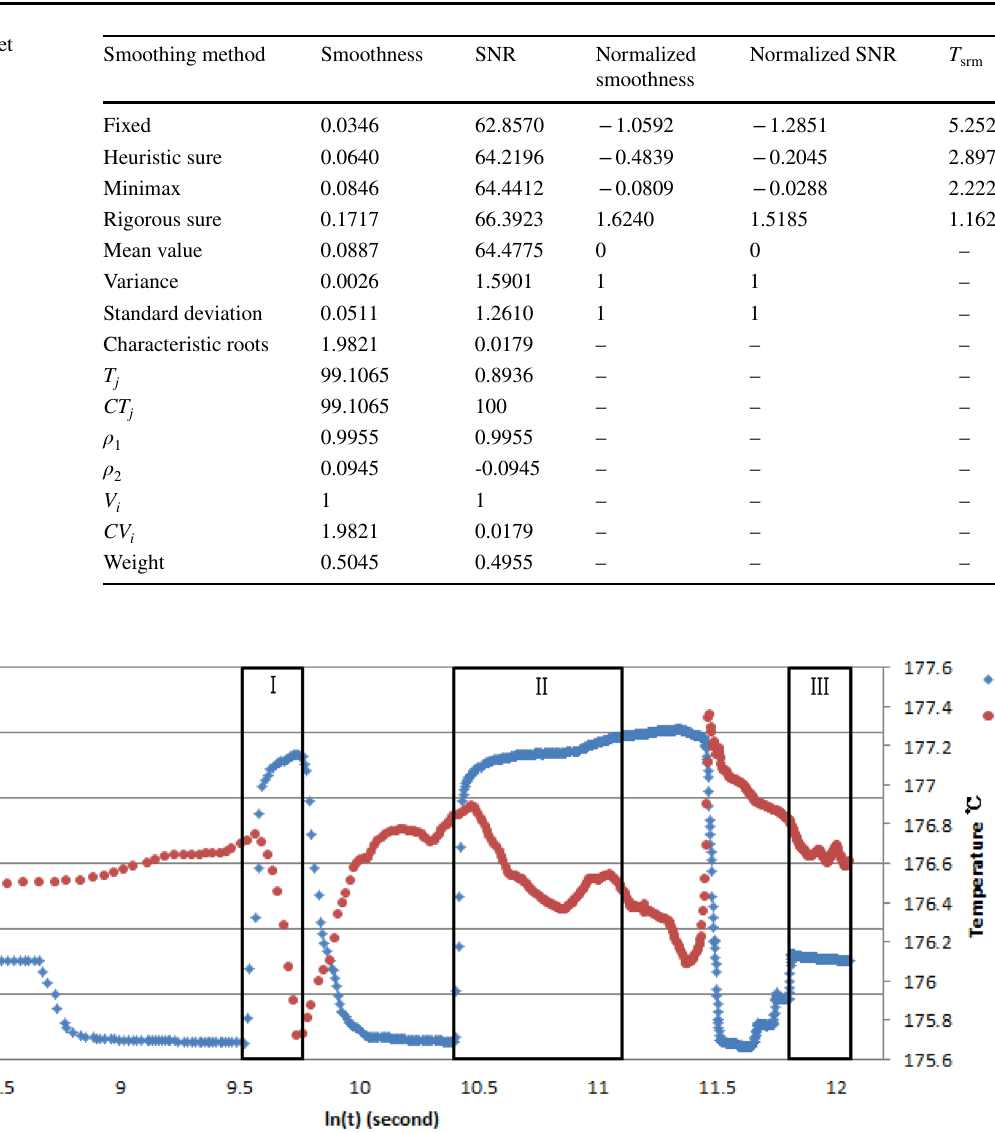
Fig. 11 Denoised pressure and temperature data of Case